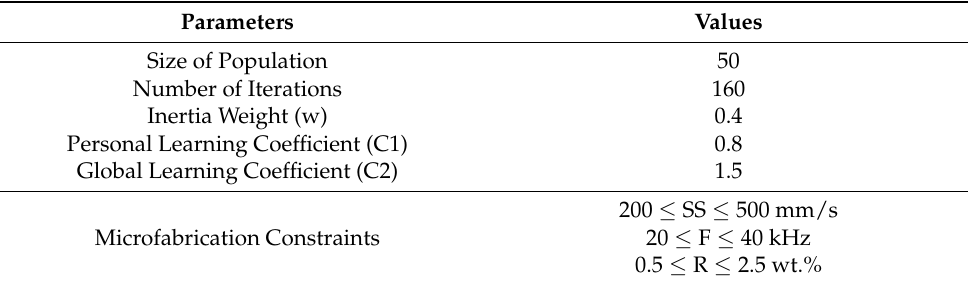
Table 8. MOPSO Parameters and microfabrication constraints.